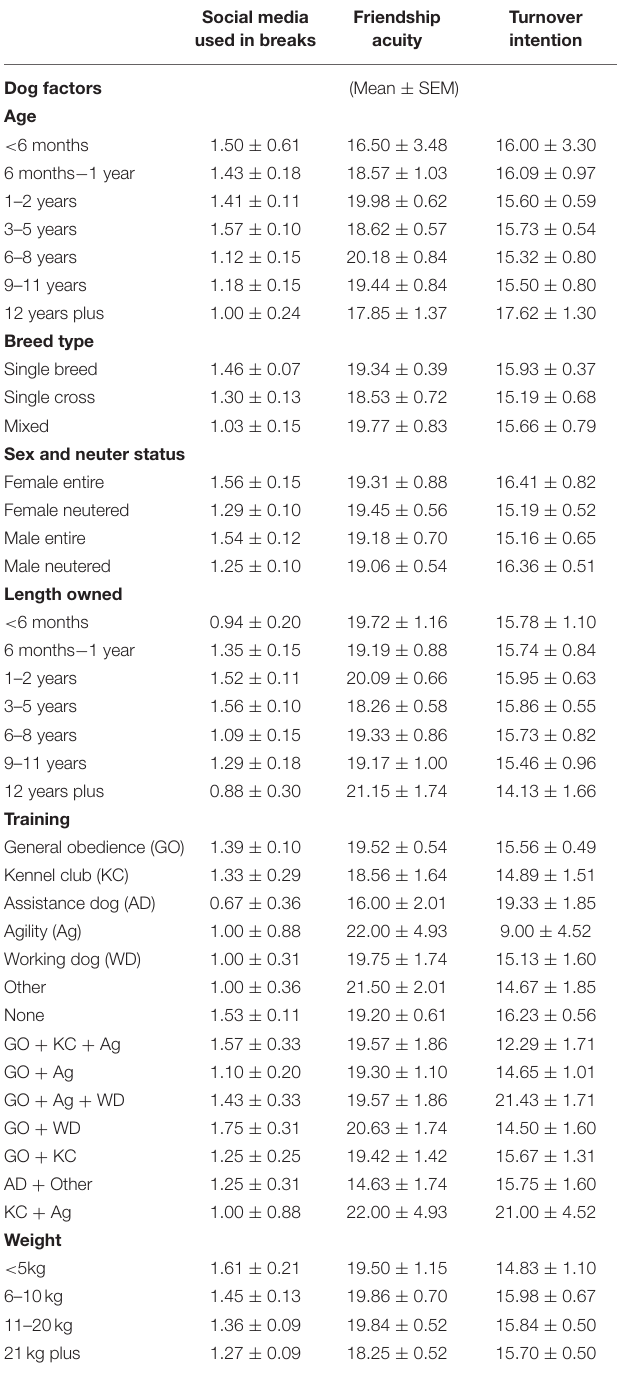
TABLE 4 | Descriptive statistics for social media use, friendship acuity and turnover intention, in employees who take their dog to their office as a function of dog-based